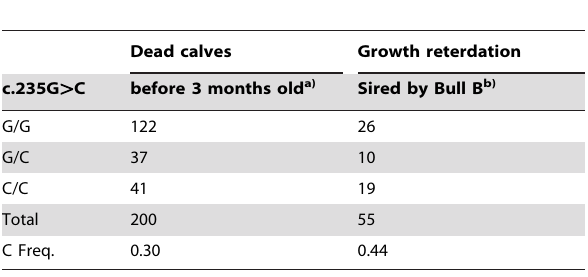
Table 4. IARS mutations in random dead calves and growth- retarded